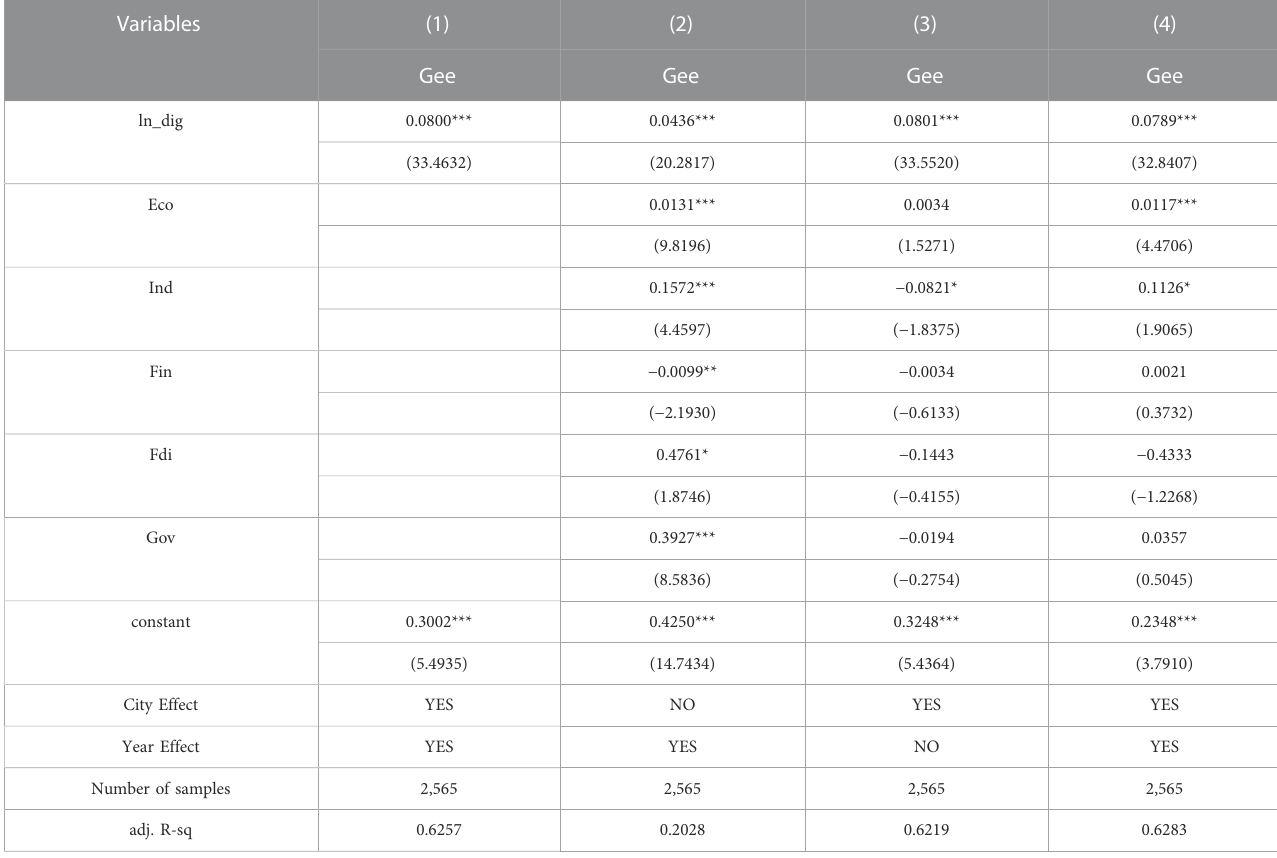
TABLE 3 Baseline regression results.